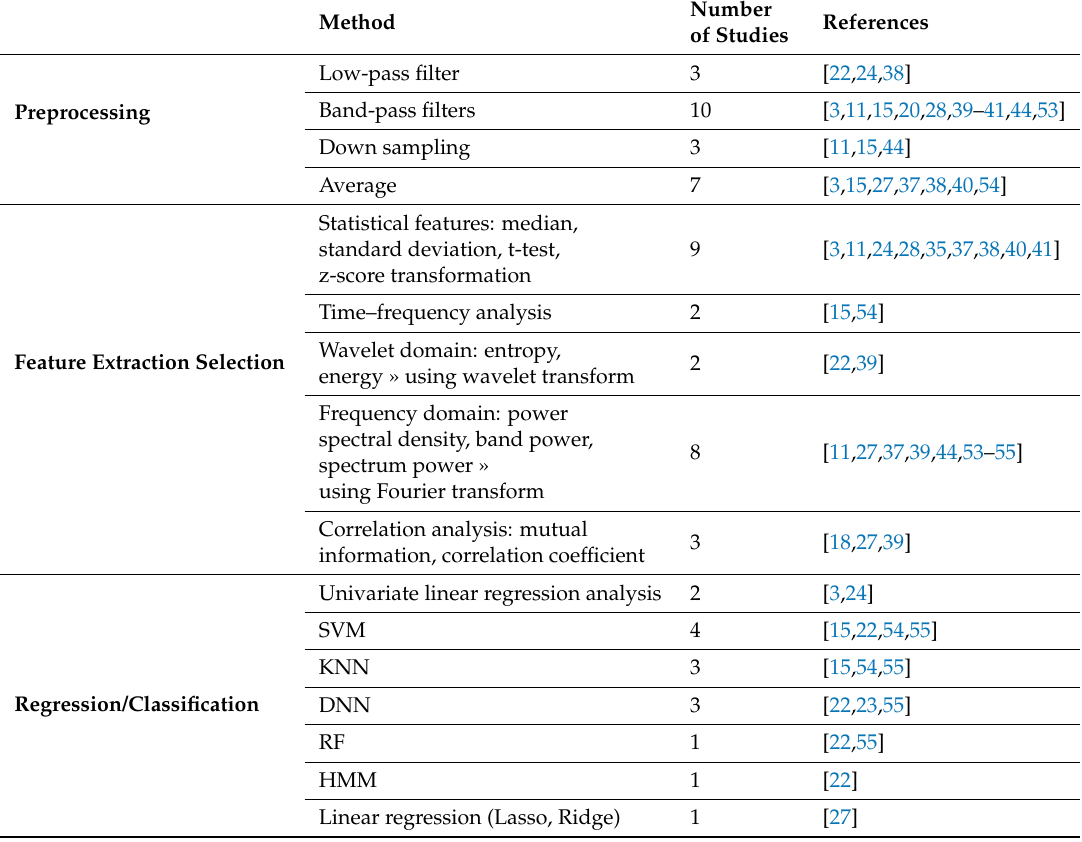
Table 5. Computational approaches for assessing the customer